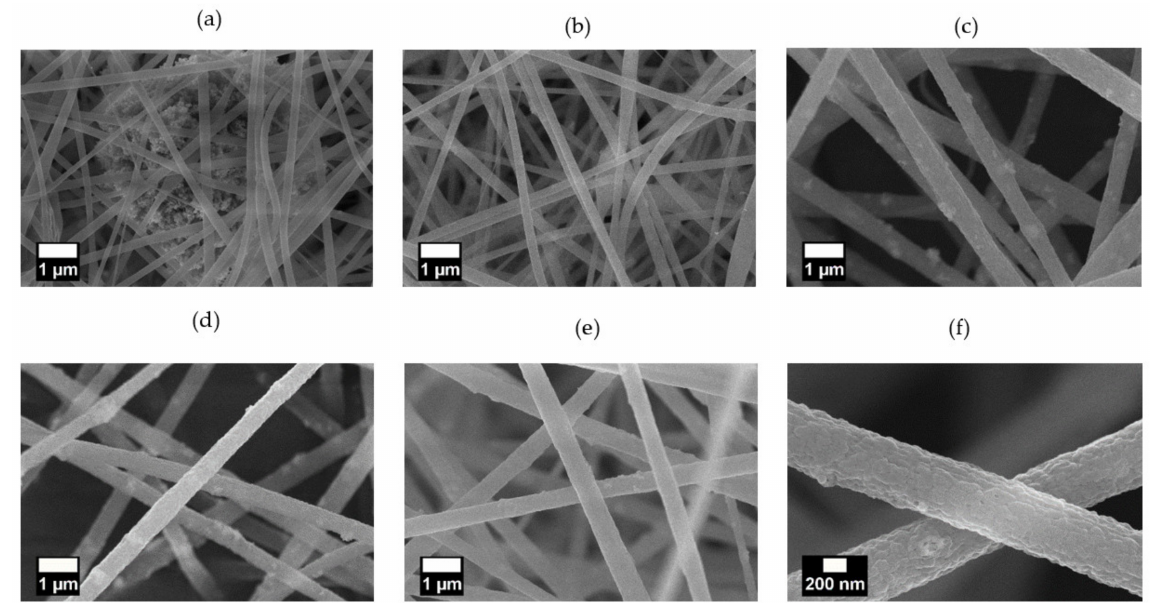
Figure 6. SEM images of ( a , b ) PZ12, ( c ) PZ12(0.5S), ( d ) PZ12(1S), and ( e ) PZ12(2S), and ( f ) highly magnified image of PZ12(0.5S) nanofibers.